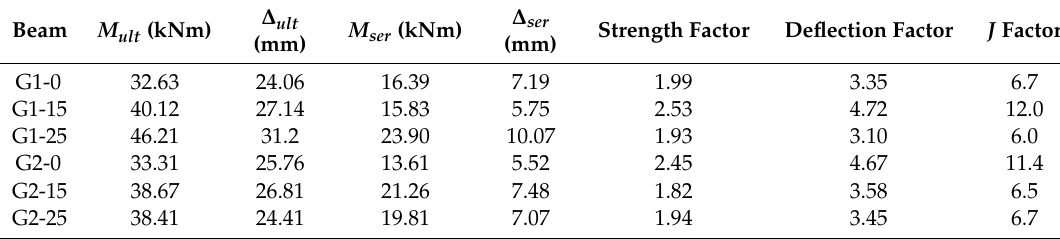
Table 7. Deformability factors for sections in the midspan for the tested beams.